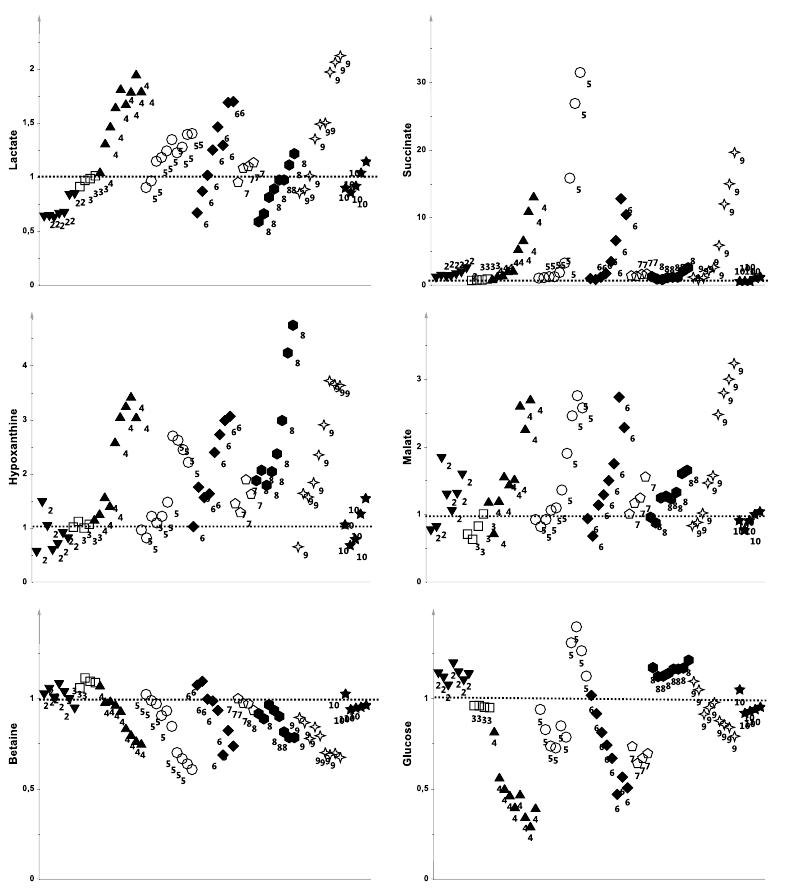
Figure 4. Modification of the fold change in concentration with respect to baseline values of the modified metabolites over the asphyxial period shown for each